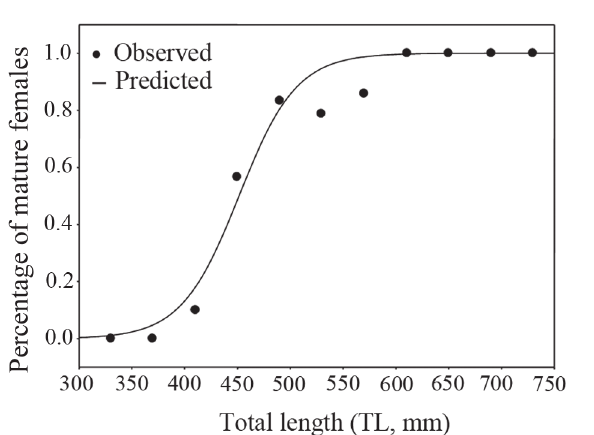
Fig. 8. Average monthly values (+ standard deviation) of the gonadosomatic index of the dusky grouper ( Mycteroperca marginata ) collected in the study area in 2007, 2008 and 2009. n =